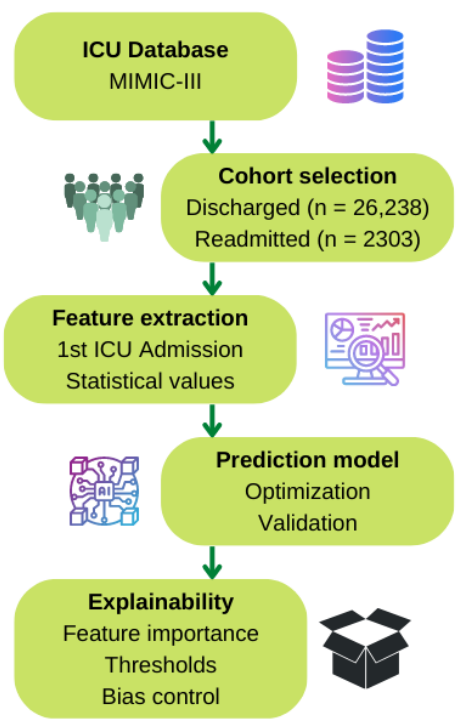
Figure 1. Pipeline of the proposed methodology.